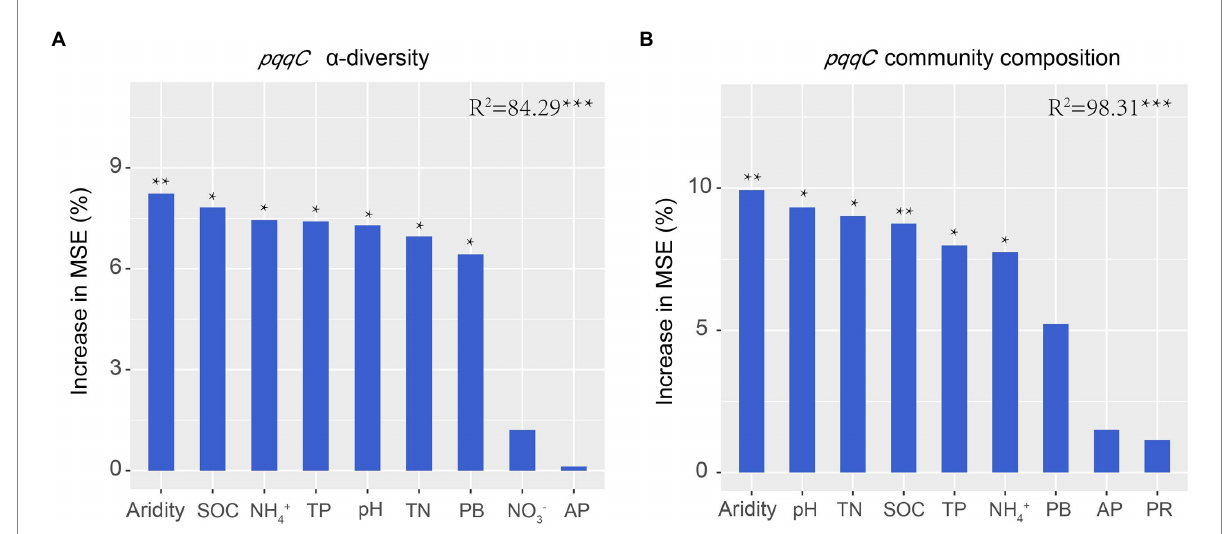
FIGURE 8 Random forest analysis shows the main predictors for the α -diversity (A) and composition (B) of pqqC community. TN, total nitrogen; SOC, soil organic carbon; TP, total phosphorus; PB, plant biomass; AP, available phosphorus; PR, plant richness.